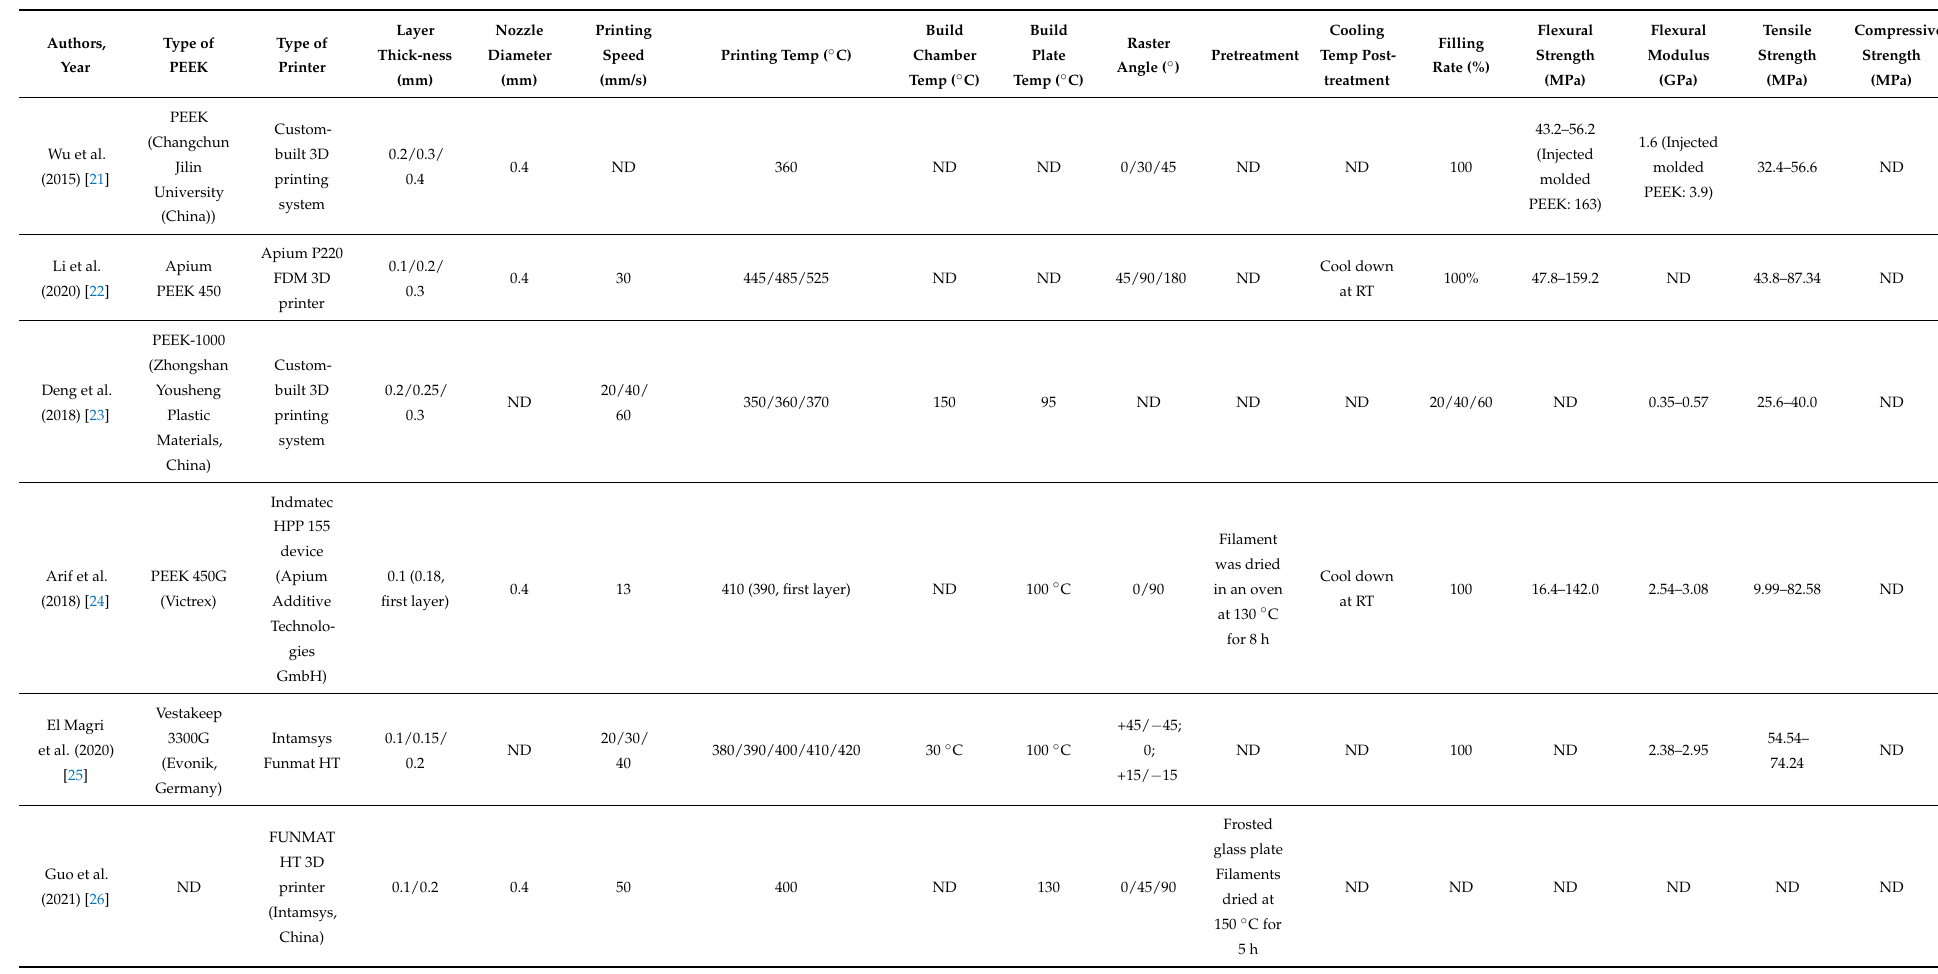
Table 1. The printing parameters and mechanical properties of FDM